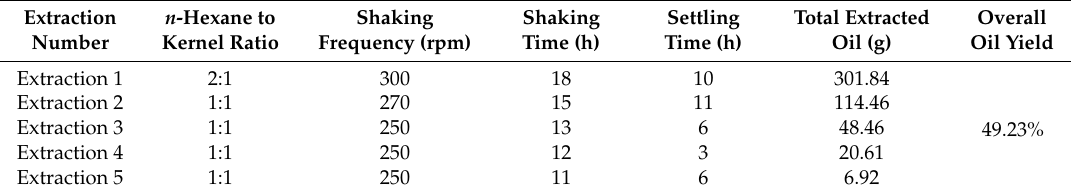
Table 3. Summary of mandarin oil extraction by n -hexane (for 1000 g of